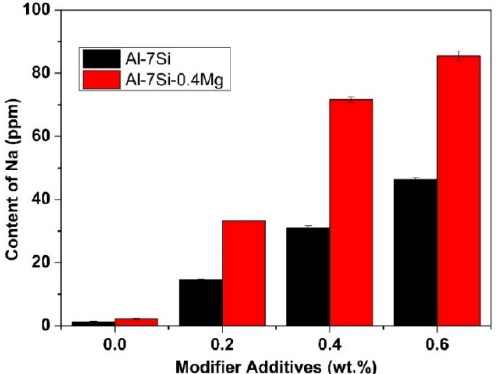
Figure 1. Effect of the addition of Na-based modifier on sodium content in commercial pure Al-7Si and Al-7Si-0.4Mg alloys.